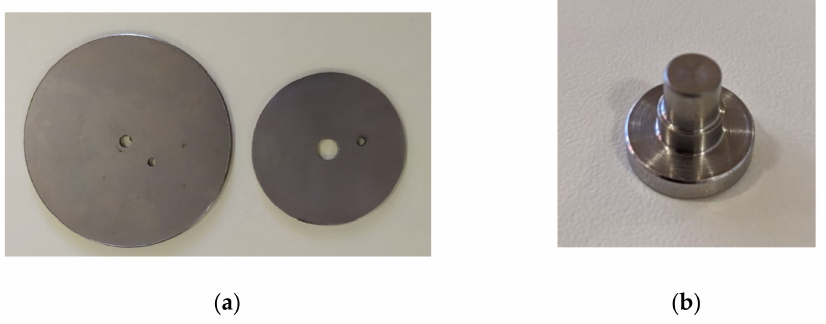
Figure 1. ( a ) specimens manufactured for cold ( left ) and hot ( right ) tribology testing and ( b ) Pin used in tribology